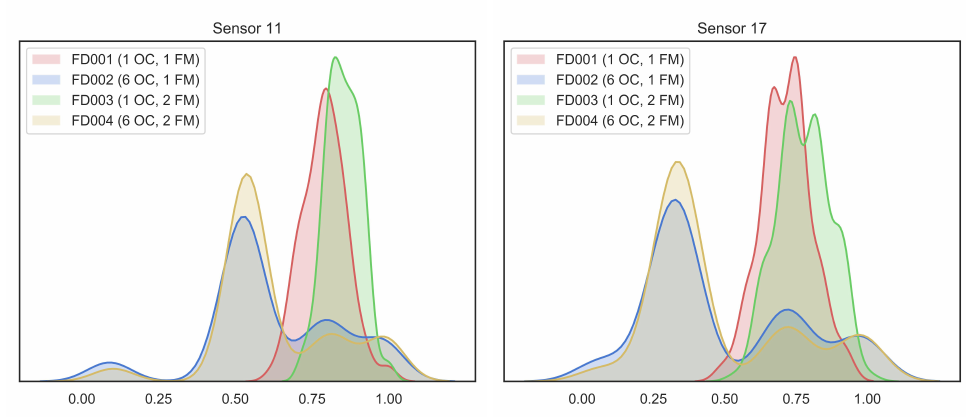
Figure 5. Visualization of data distribution discrepancy between C-MAPSS subsets.